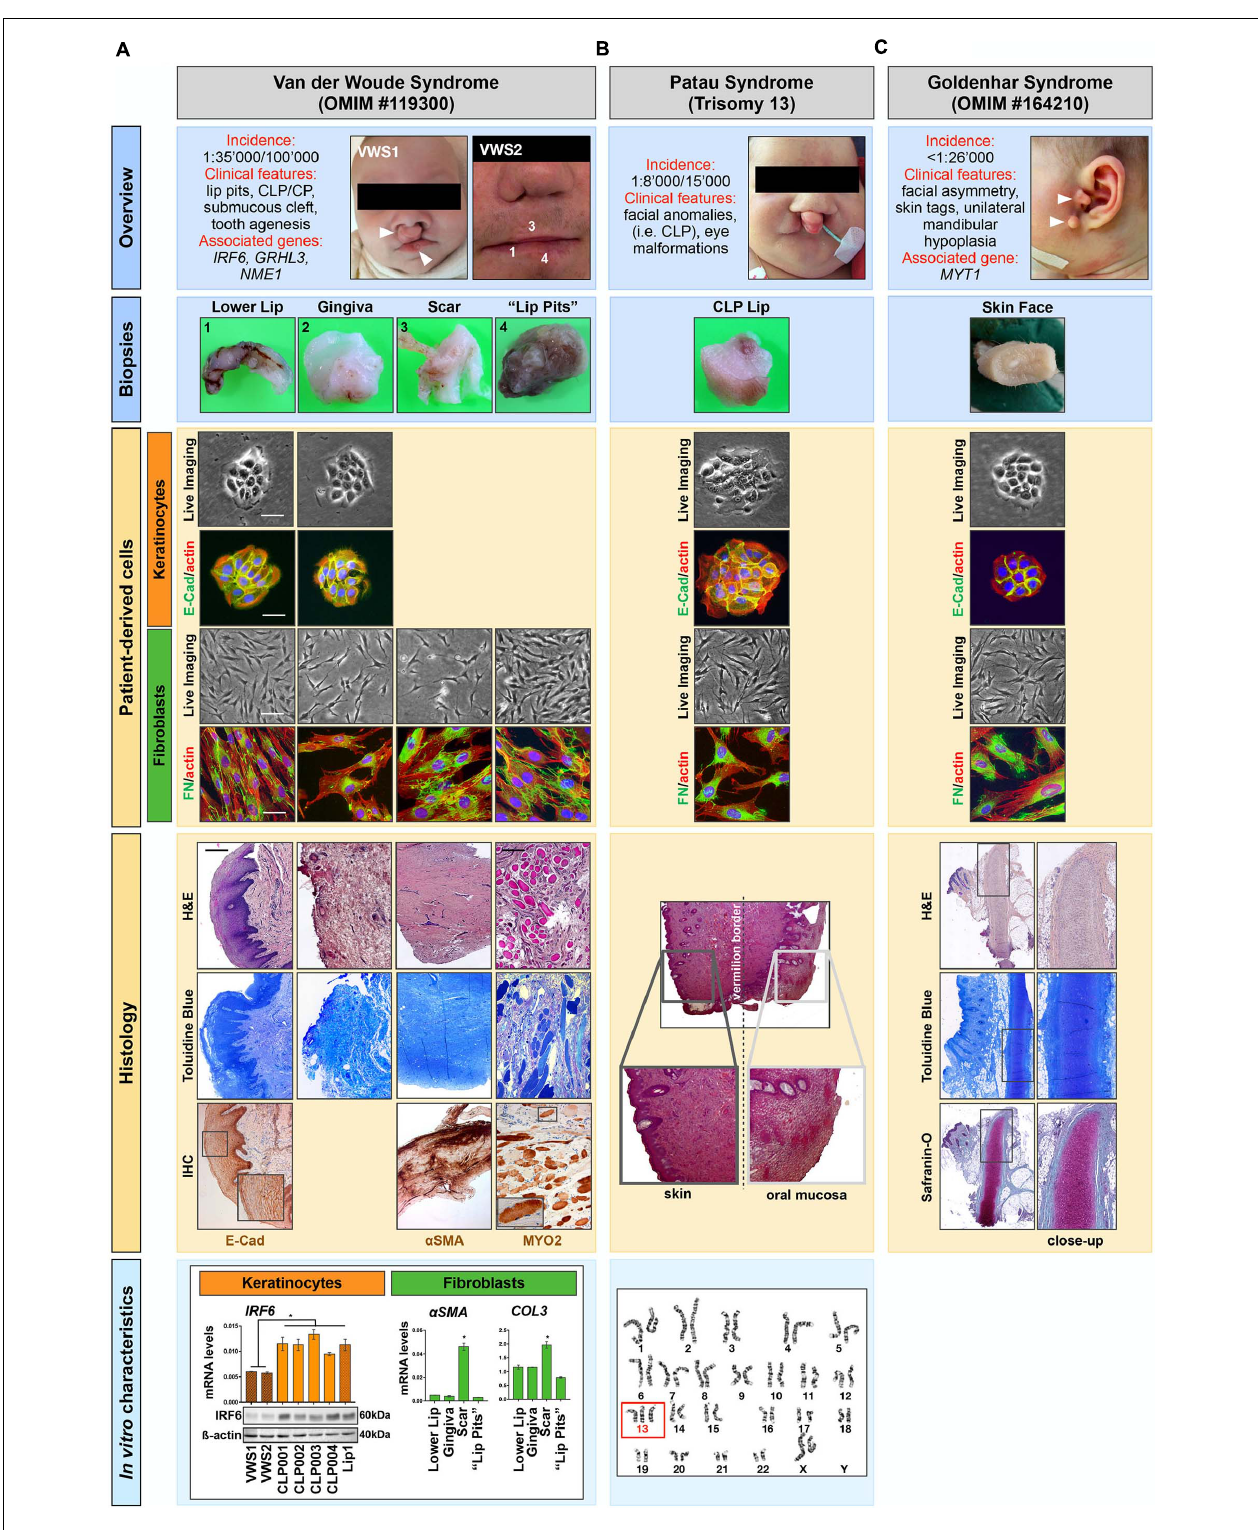
FIGURE 5 | Patient-derived cells can serve as promising research tools for studying rare human diseases. Our cohort of tissue donors encompasses individuals affected by (A) Van der Woude syndrome (VWS), (B) Patau syndrome, and (C) Goldenhar syndrome (GH). Overview : A brief description of the rare human diseases is shown as well as the clinical appearance of the tissue donors. Arrowheads indicate typical phenotypes such as bilateral lip pits and orofacial clefts (VWS1, A ), and